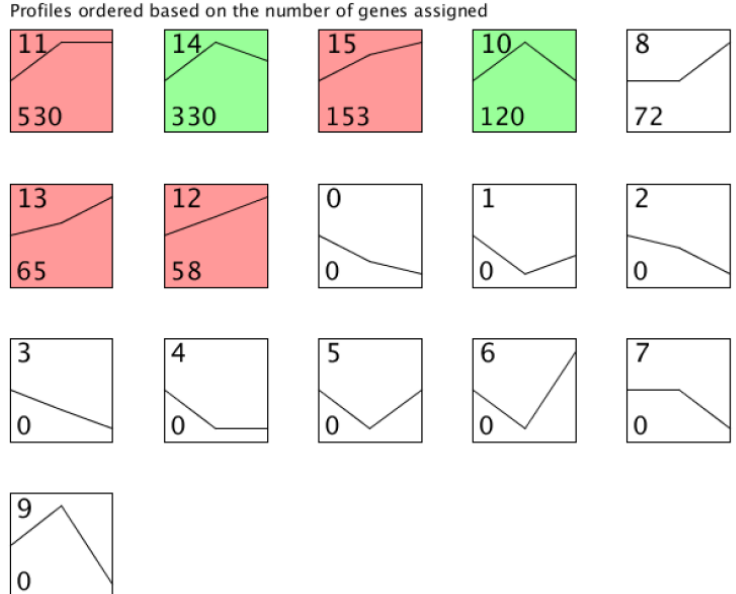
Figure 3. Expression profile clusters of lncRNAs across MPV, F 1 , allotetraploid S 14 . The number in the top left-hand corner of a profile box is the profile ID number; bottom number represent number of genes assigned to the expression profile. The colored profiles had a statistically significant number of genes assigned. Non-white profiles of the same color represent profiles grouped into a single cluster. MPV: mid-parent value.